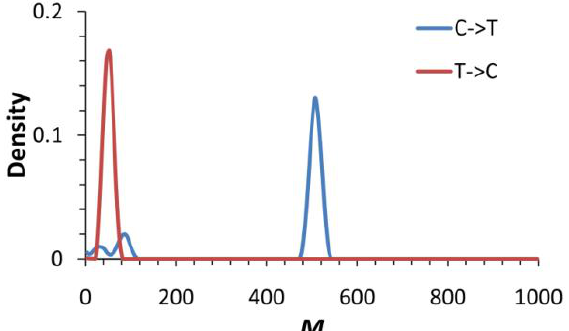
Figure 6. Posterior distribution of migration rate ( M ) over all loci between the cultivar accession and the Taiwan accession estimated by using the MIGRATE-n [34] analysis.